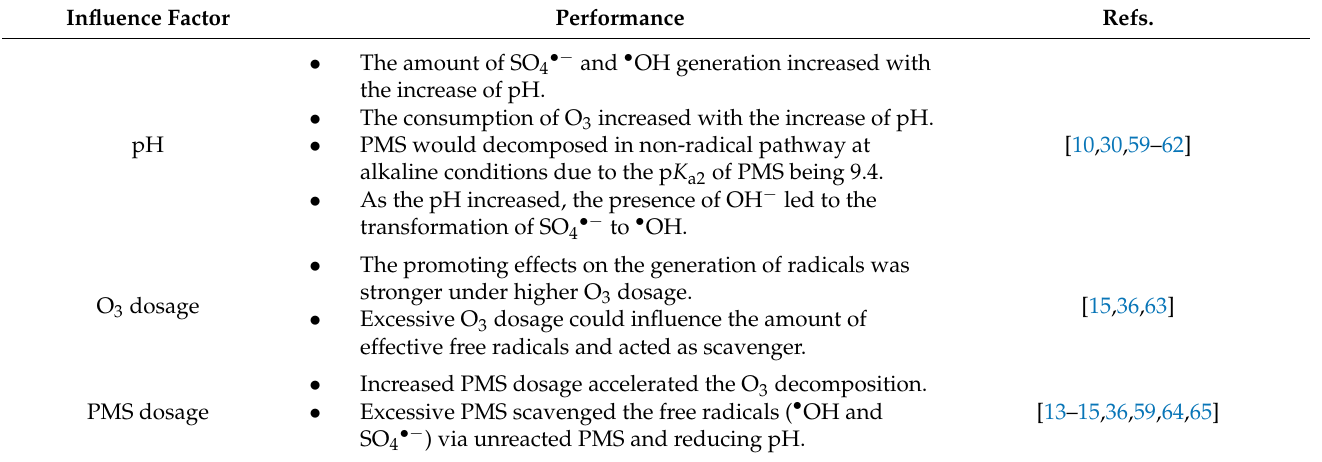
Table 1. The influence of reaction conditions on the O 3 /PMS system.